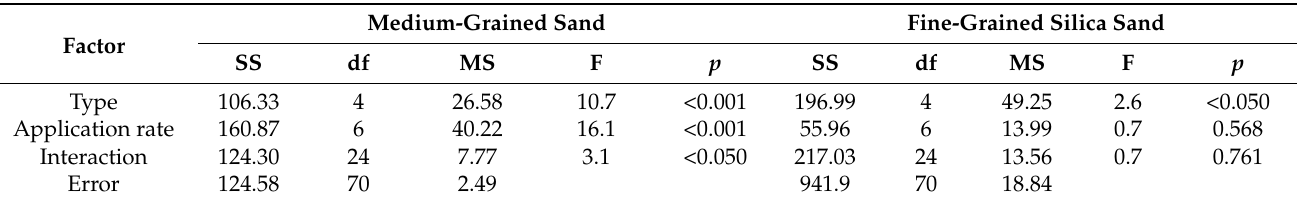
Table 4. Results of two-way ANOVA ( α = 0.05) of wind tunnel test data from Phase 2, investigating the effect of the application rate on the wind-induced soil loss.